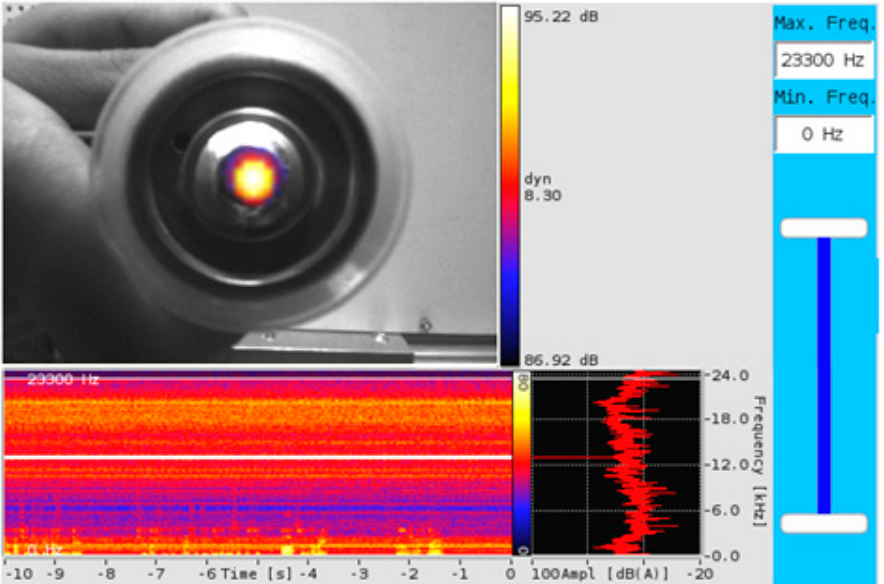
Figure 19. The SoundCam interface and full-field image of airborne radiation from piezo-actuator (frequency 13,100 Hz).